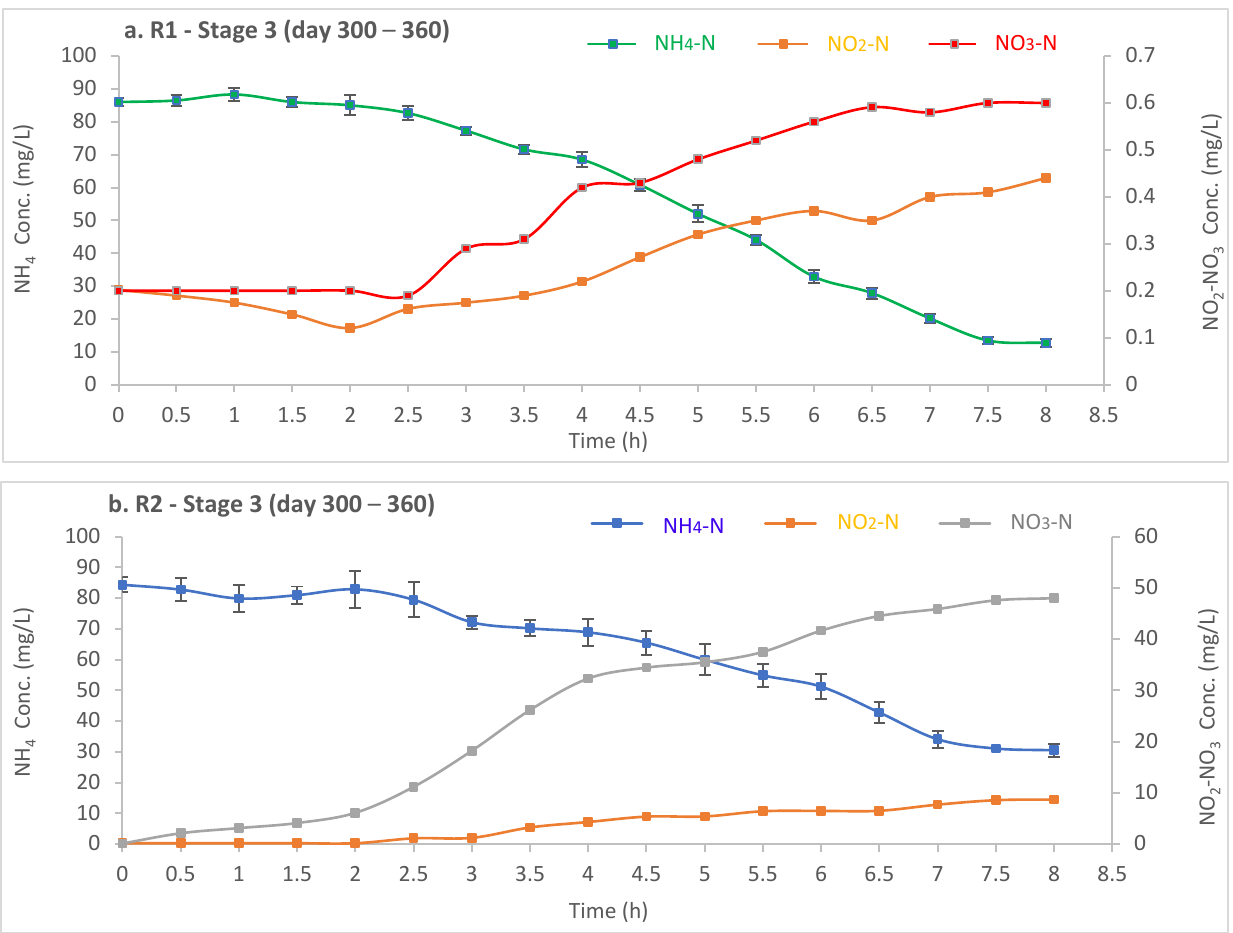
Figure 8. Profile of nitrogen removal distributed over a typical cycle during stage III in ( a ) R1 and ( b ) R2. Overall, the performance of R1 was continuing in the same trend of enhancement R1 might be due to the high strength of influent wastewater characteristics (high